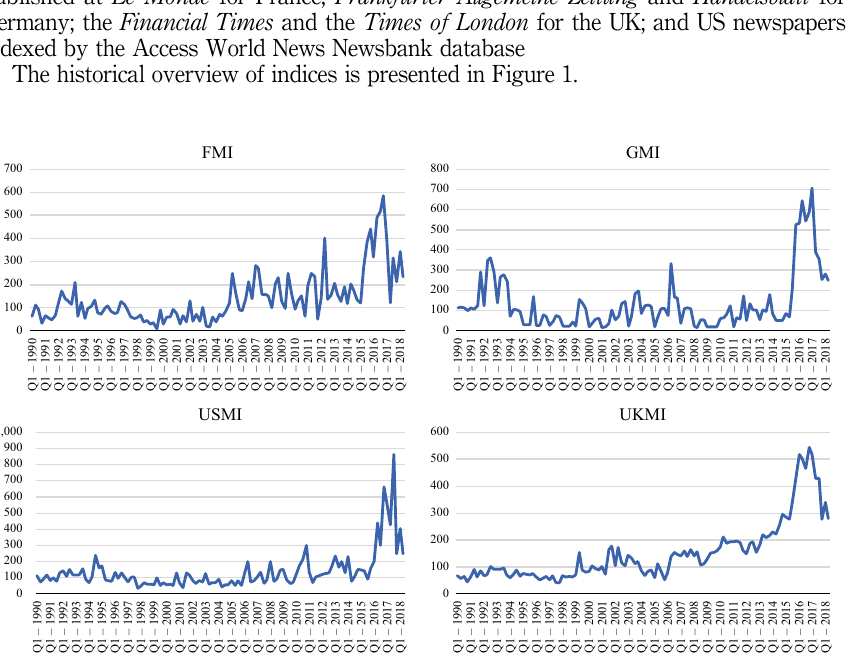
Figure 1. Migration policy uncertainty